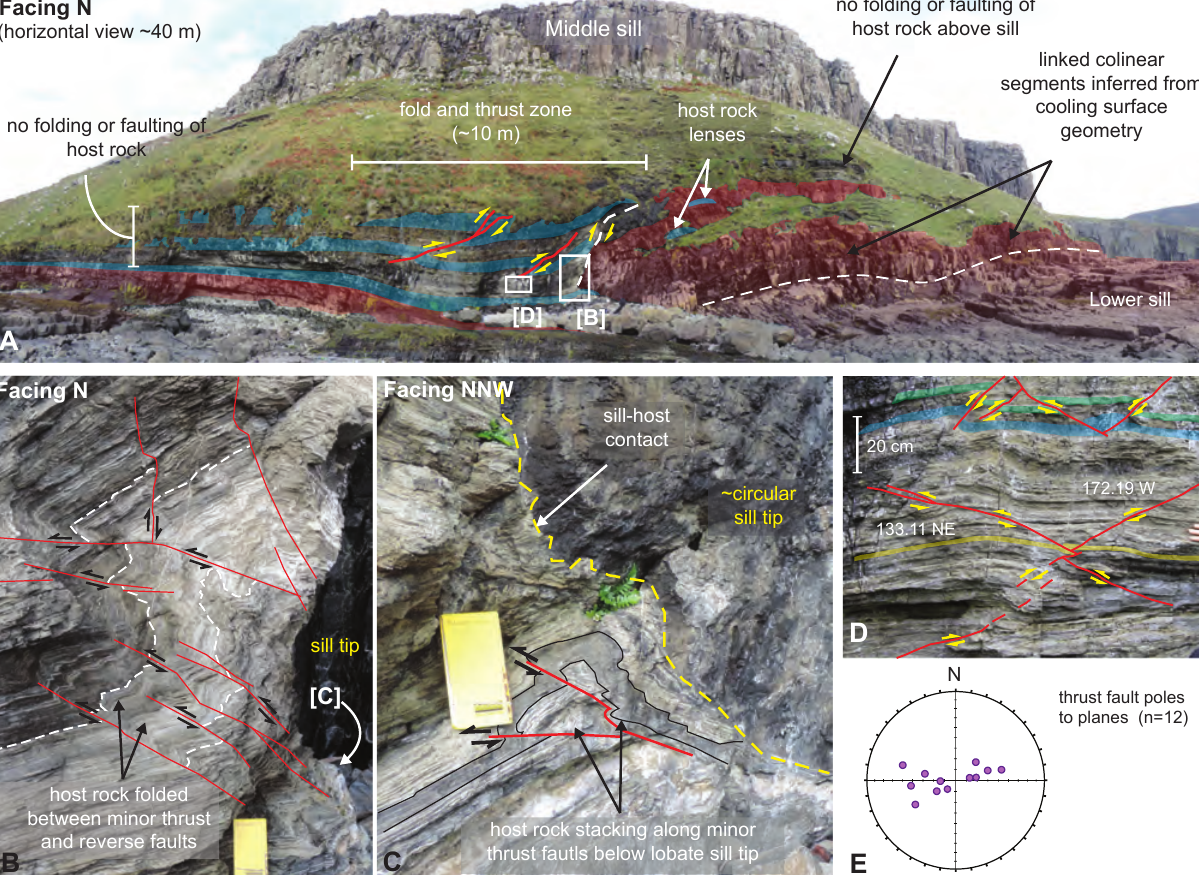
Figure 10: Fold and thrust zone ahead of a thick sill with a circular tip (Location shown on Figure 4). [A] Fold and thrust zone ahead of sill segment (highlighted red); marker units are highlighted blue. Major thrust faults verge towards the sill segment; exposed host units above the segment are not folded or faulted. [B] Minor thrust and reverse faults at the sill-host contact; notebook for scale. [C] Host rock stacking across thrust faults below the tip; notebook for scale Centimetre-scale conjugate thrust faults below one of the major thrust faults. [D] Minor thrust and reverse faults ahead of the sill-host contact; notebook for scale. (Unannotated photos [A]–[D] available in Supplementary File 1). [E] Equal-area lower-hemisphere stereonet with thrust faults ahead of the sill tip plotted as poles to planes (Data available in Supplementary File